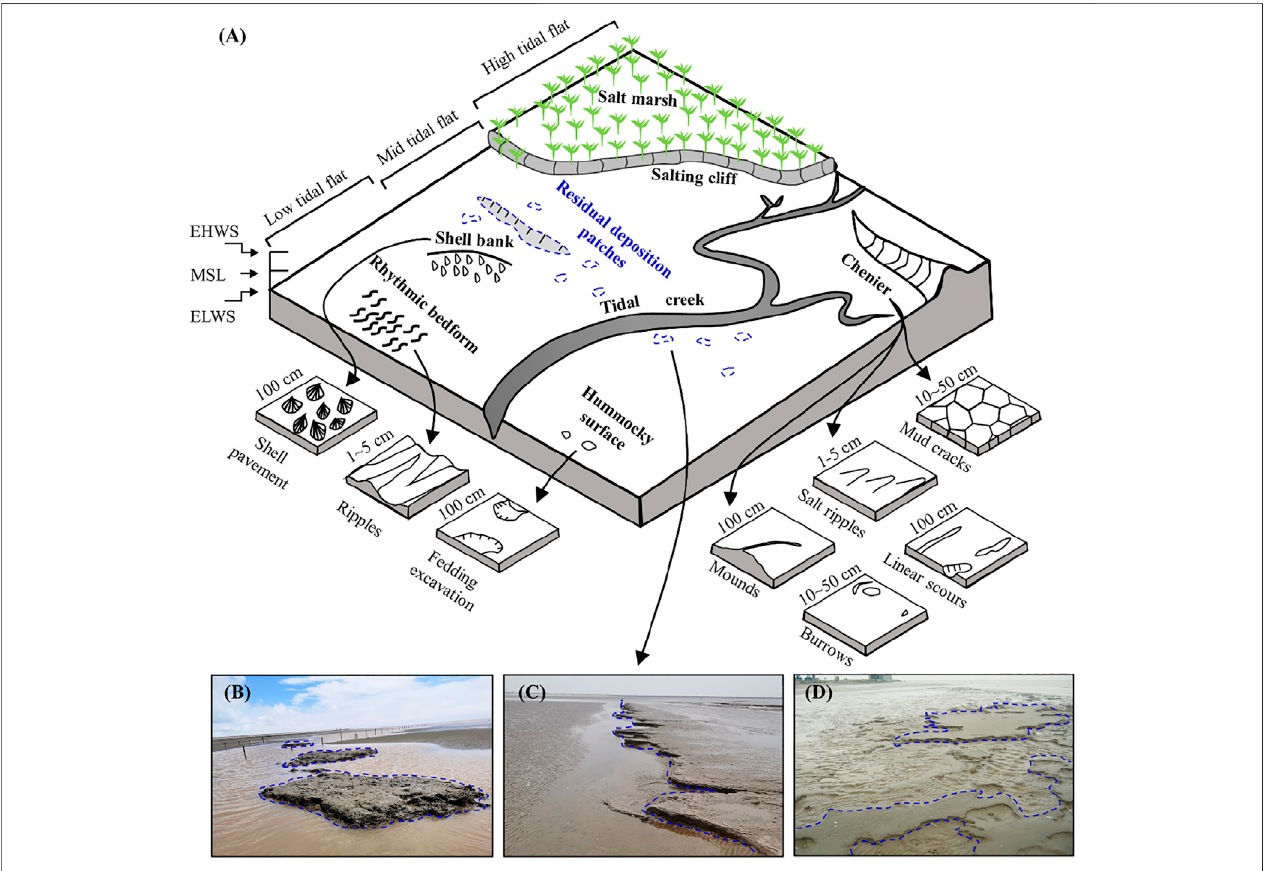
FIGURE 1 | Generalized geomorphology of tidal fl ats. (A) Macroscale geomorphology of tidal fl at and morphological characteristics of mesoscale and microscale geomorphology units. (B – D) Photos of intertidal hummocky patches taken in three major tidal fl at areas in China: (B) The tidal fl at in the Yangtze River Delta, photographedinAugust2021; (C) Tidal fl atinDafengalongJiangsucoast,photographedinMay2021; (D) Tidal fl atintheYellowRiverDelta,photographedinJuly2008.